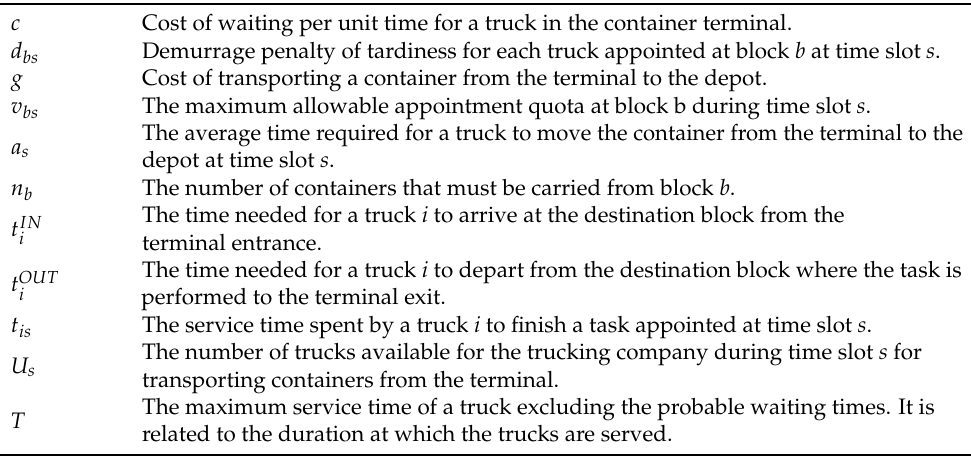
Table 1. Symbols and description of the used parameters.